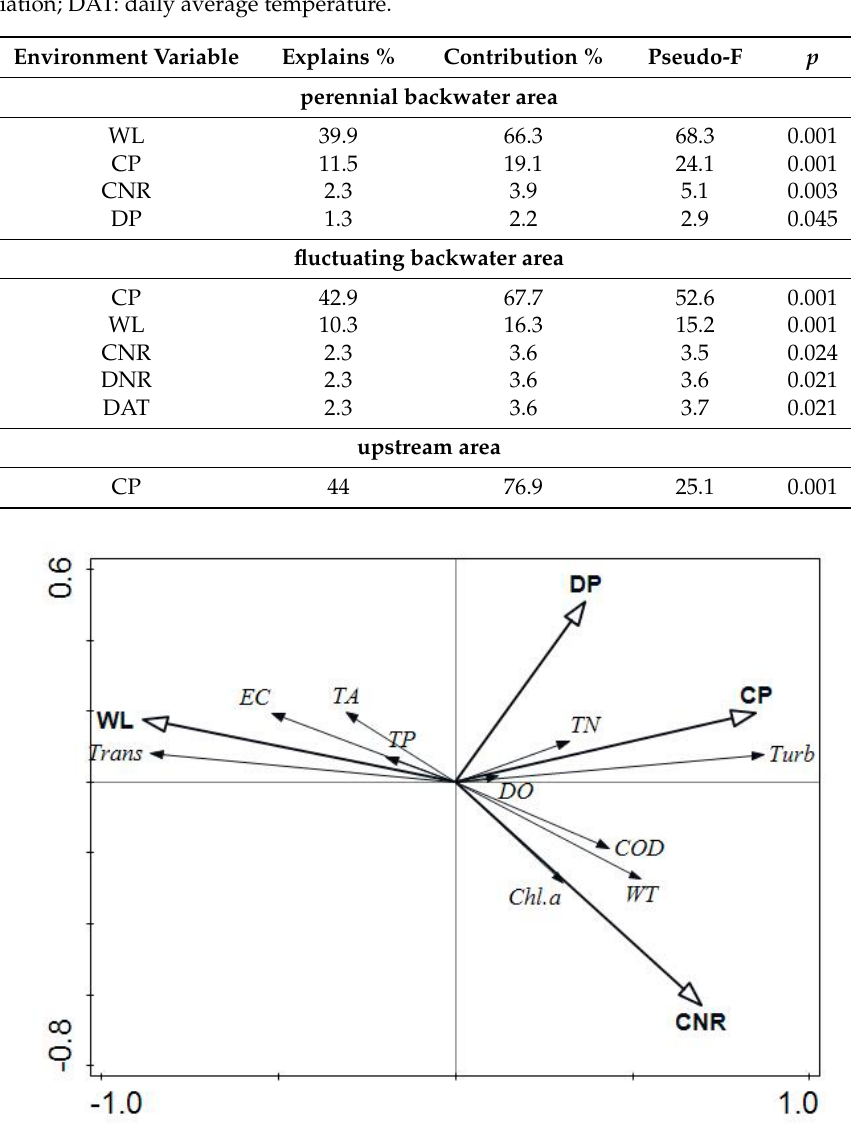
Figure 6. Redundancy analysis (RDA) ordination biplot of water environment variables and meteo-hydrological factors in the perennial backwater area of LR, China.